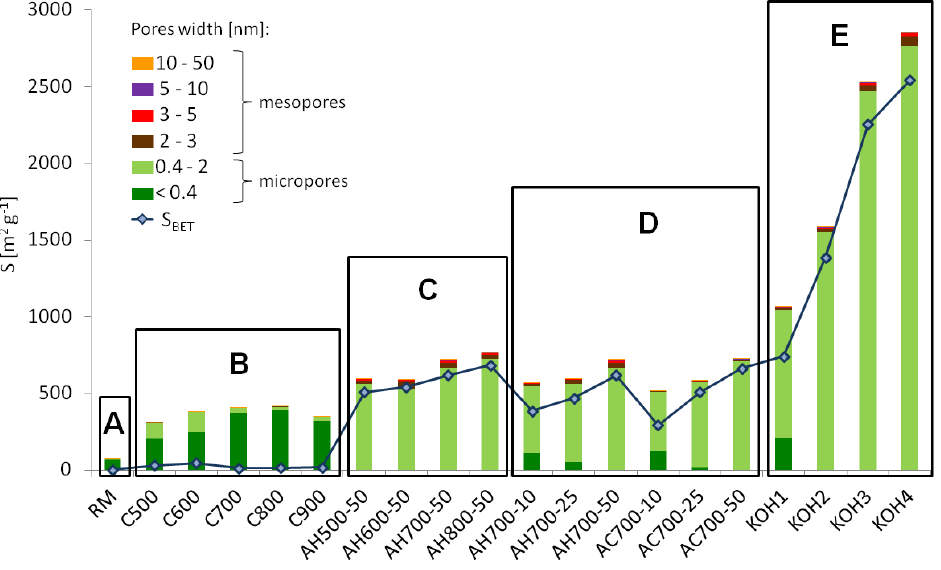
Figure 4: Distribution of micro- and mesopores surface area according to pore size and BET surface area in raw material (A), chars (B) and activated carbons obtained by steam activation at different temperature (C), steam and carbon dioxide activation to different burn-off (D) and chemical (KOH) activation